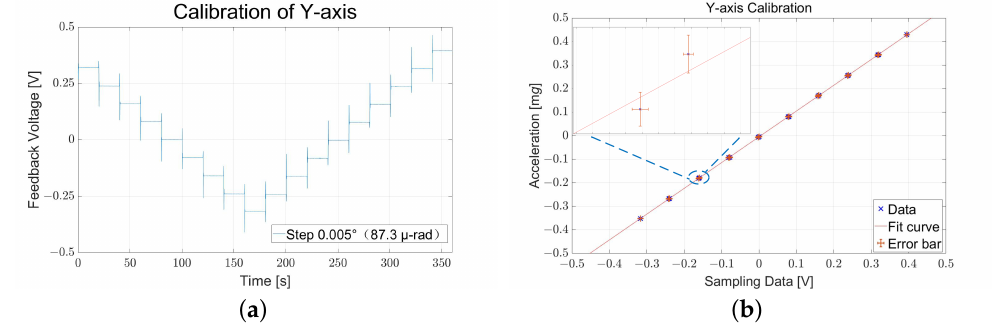
Figure 7. Scale factor and range calibration results of horizontal (Y). ( a ) The readout voltage variation with the adjustment of the platform. ( b ) Calibration result, in which “ × ” is the data used for the tilt test, while the zoomed-in picture shows error bars and test point differences introduced by the non-repeatability of the